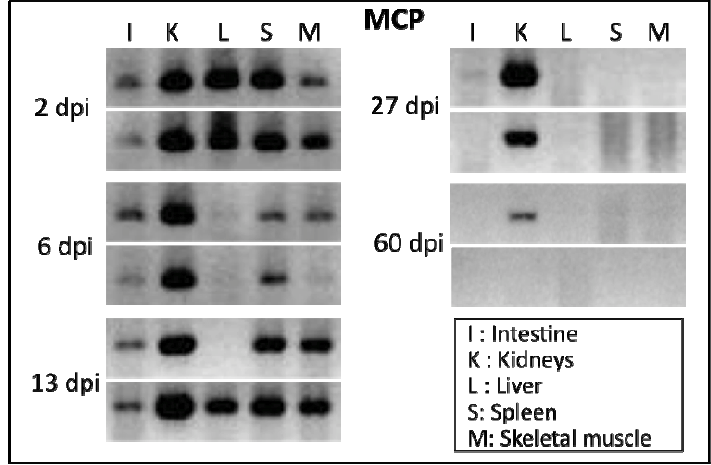
Figure 1. Slow clearance of FV3 DNA in X. tropicalis . FV3 DNA detected by PCR (35 cycles) using primers specific for the major capsid protein (MCP) on genomic DNA purified from various tissues of outbred X . tropicalis adults that were infected with FV3 by i.p. injection of 1 × 10 6 PFU for 2, 6, 13, 27 and 60 days (2 individuals per time